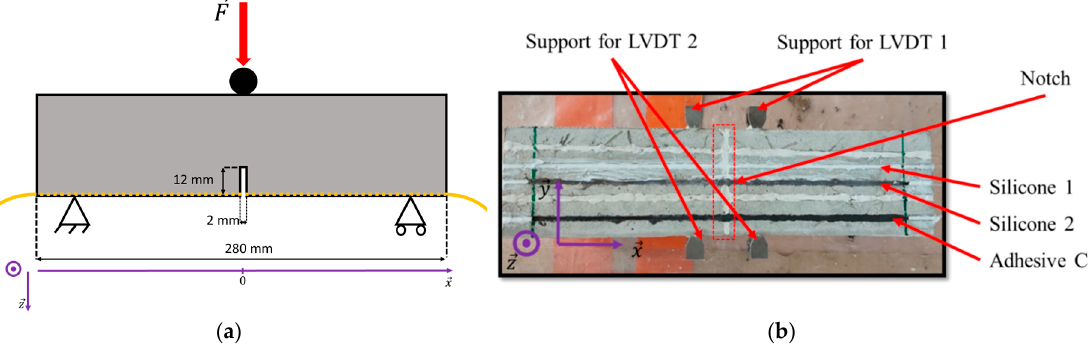
Figure 11. ( a ) Scheme of the bending test configuration; ( b ) bottom view of the prismatic specimen used for the three-point bending test.